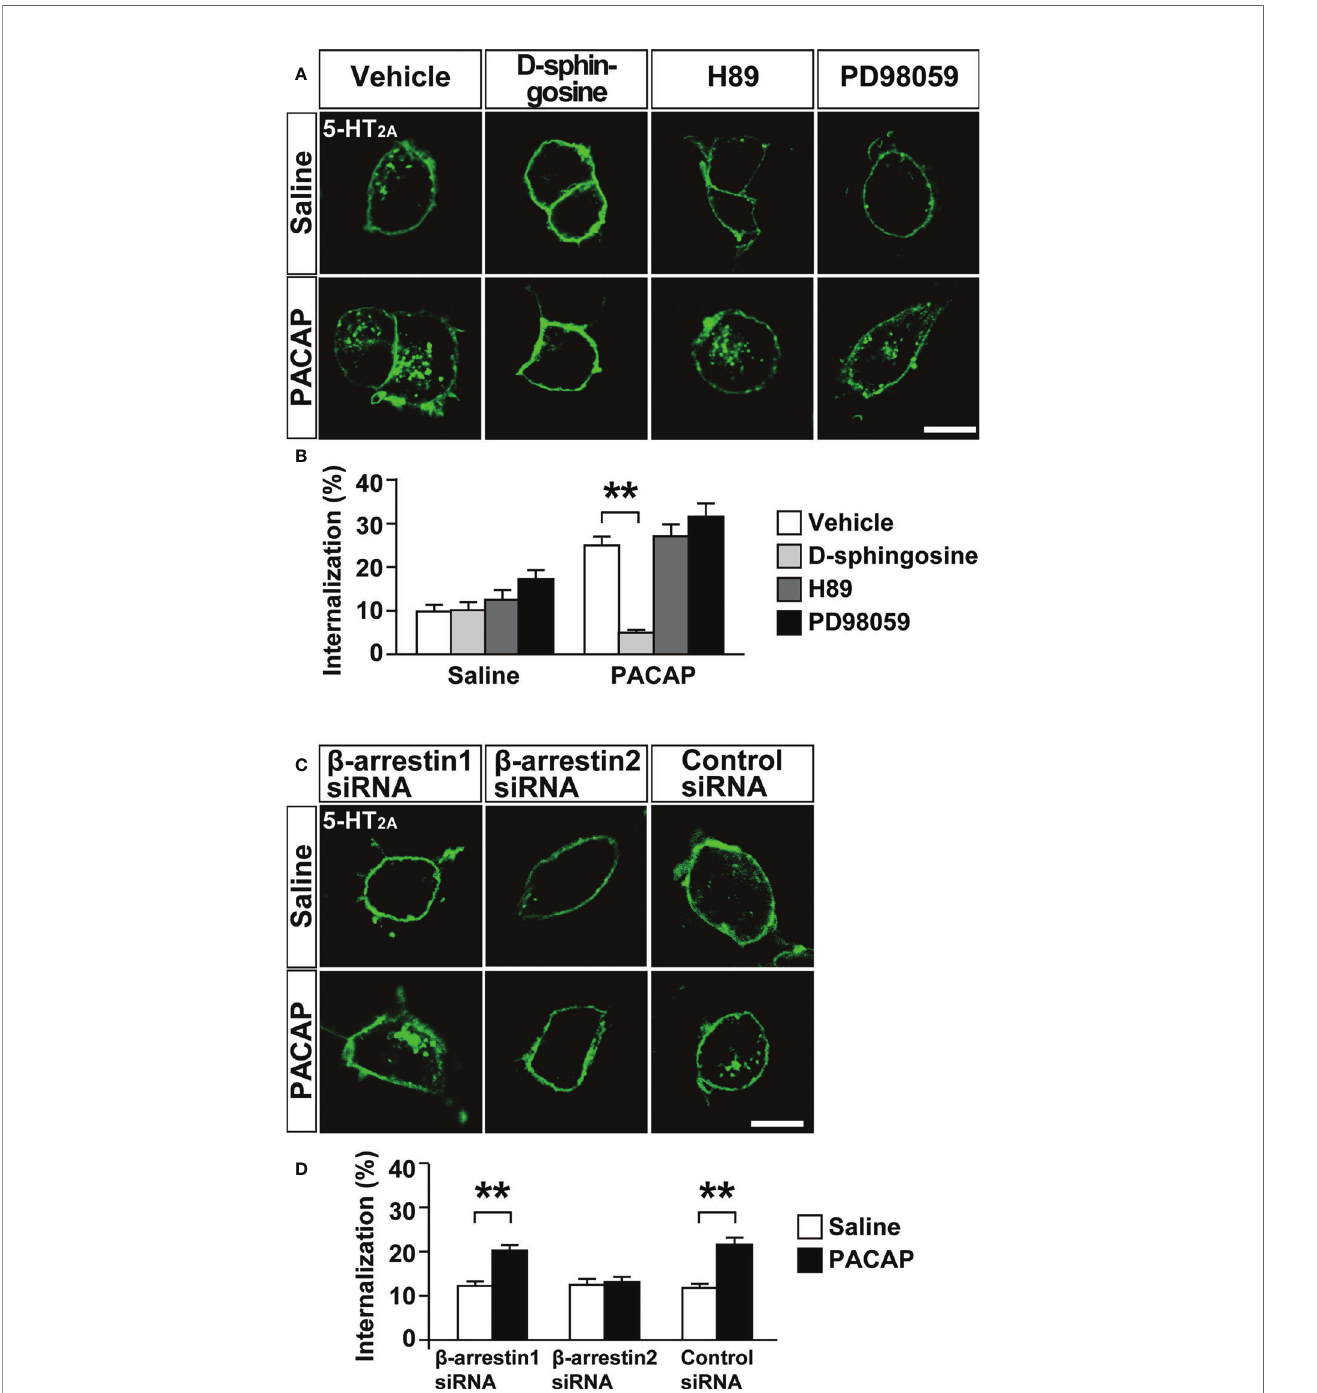
FIGURE 3 | Effect of kinase inhibitors or b -arrestin silencing on PACAP-induced 5-HT 2A internalization in HEK293T cells. (A) Representative images of HEK293T cells transfected with 5-HT 2A . The cells were pretreated with 50 m M D-sphingosine (PKC inhibitor), 20 m M H89 (protein kinase A inhibitor), 50 m M PD98059 (MEK inhibitor) or saline for 30 min, labeled with Alexa Fluor 488 HaloTag membrane impermeable ligand for 15 min and then treated with 1 m M PACAP or saline for 30 min. Scale bar, 10 m m. (B) Quanti fi cation of 5-HT 2A internalization. Values are the mean ± SEM of 34 – 51 cells obtained from three independent experiments. ** p < 0.01, two-way ANOVA followed by the Tukey-Kramer test. (C) Representative images of HEK293T cells cotransfected with 5-HT 2A plus b -arrestin1 siRNA, b - arrestin2 siRNA or the negative control siRNA. The cells were labeled with Alexa Fluor 488 HaloTag membrane impermeable ligand for 15 min and then treated with 1 m M PACAP or saline for 30 min. Scale bar, 10 m m. (D) Quanti fi cation of 5-HT 2A internalization. Values are the mean ± SEM of 77 – 87 cells obtained from three independent experiments. ** p < 0.01, two-way ANOVA followed by the Tukey-Kramer